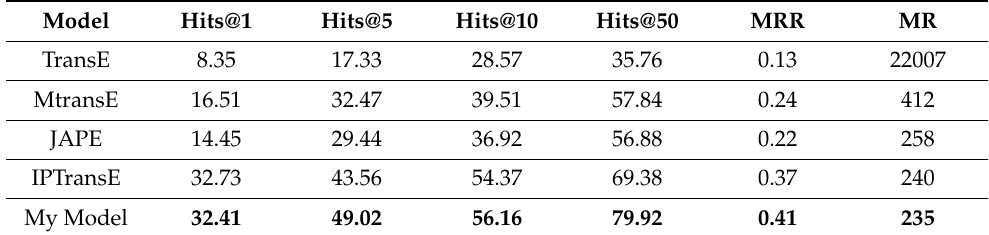
Table 3. D-W15K entity alignment results.